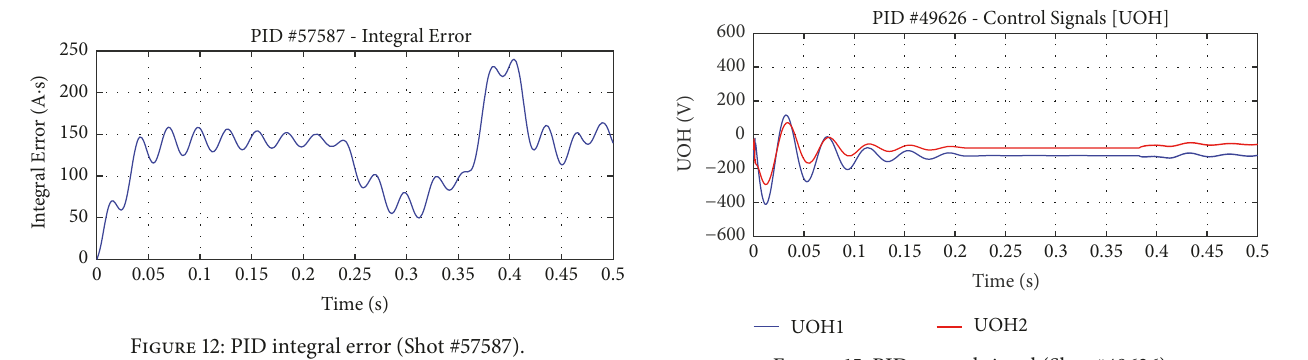
Figure 15: PID control signal (Shot #49626).